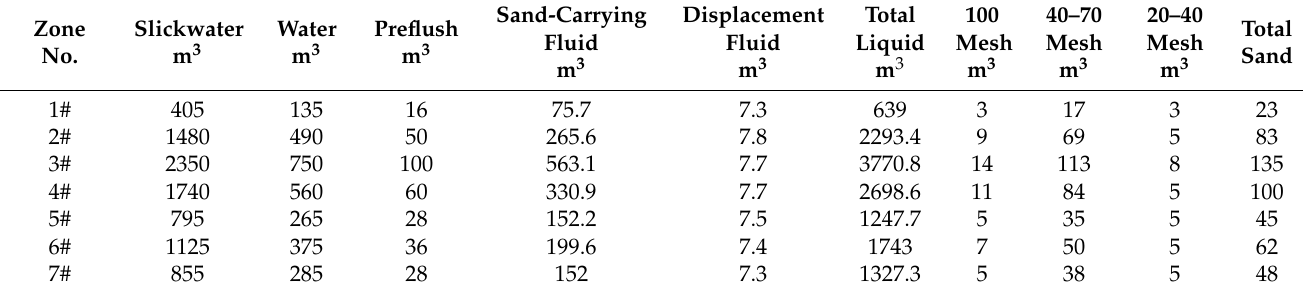
Table 3. Results of the pilot well after hydraulic fracturing design optimization.